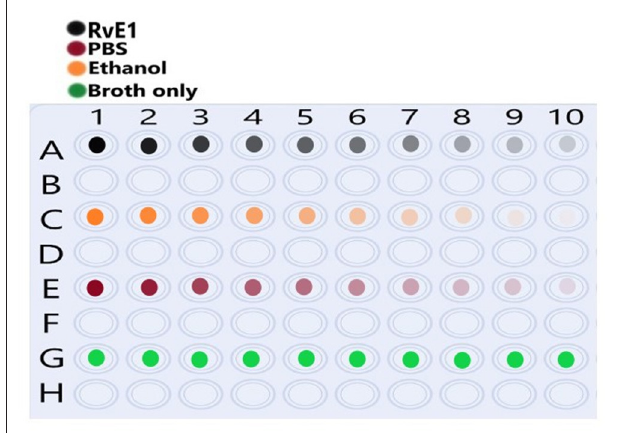
FIGURE 1 | Illustration of the well platesused for serial dilution of each tested group. Row (A) shows Resolvin E1 (RvE1) serial dilution (1:1) from wells 1–10 as color intensity. Row (C) shows ethanol serial dilution (1:1) from wells 1–10 as color intensity. (E) Shows phosphate-buffered saline (PBS) serial dilution (1:1) from wells 1–10 as color intensity. Row (G) shows the brain-heart infusion (BHI) broth medium only without dilution.